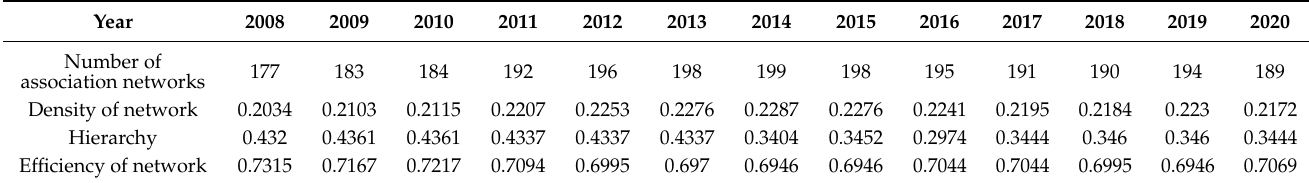
Table 5. Overall structural features of regional economic growth in China.